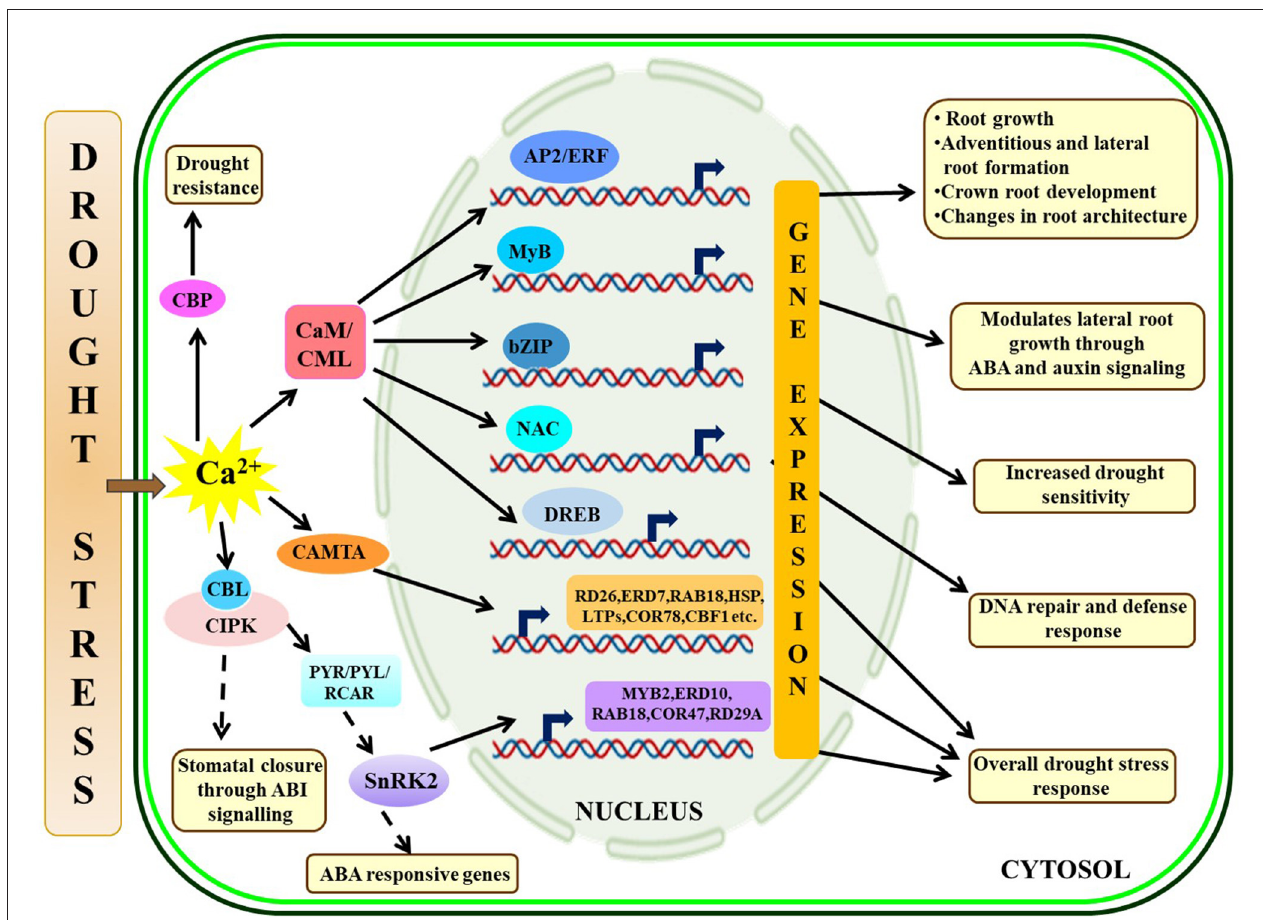
FIGURE 2 | Illustrative representation of crosstalk among Ca 2 + signaling components under drought-stressed condition, Drought stress-mediated [Ca 2 + ] cyt fluctuations activate Ca2 + -interacting partners and provide response against the stress through varying mechanisms like CaM- and CAMTA-mediated gene expressions through several TFs conferring drought tolerance, CBL-CIPK interaction controls water loss through stomatal closure, PYR/PYL/RCAR regulates ABA pathway critical in stress-management. The solid arrow represents direct activation; the dotted arrow represents indirect activation via some intermediates.